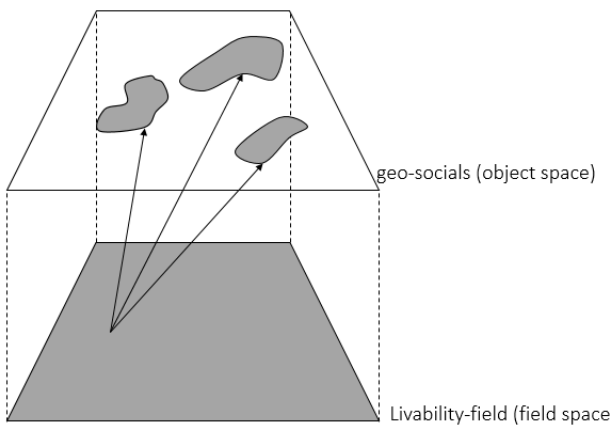
Figure 3. Relationship between the livability-field and the geo-social. The figure is inspired by the ‘one location to many objects’ relationship proposed by Cova and Goodchild [44].